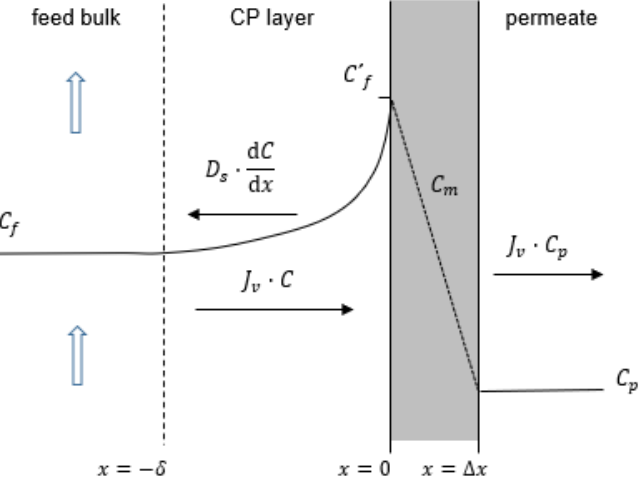
Figure 2 outlines the mass transfer model due to the increase in concentration in the area near the membrane (inner layer) due to the accumulation of retained solute.